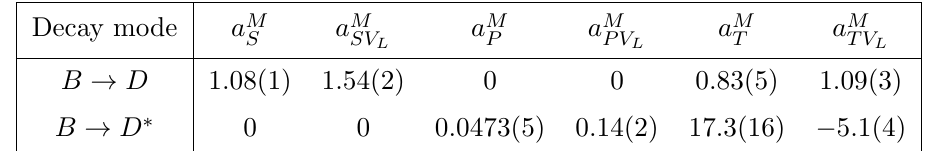
, g S and g T for the L R and a D (cid:3) i